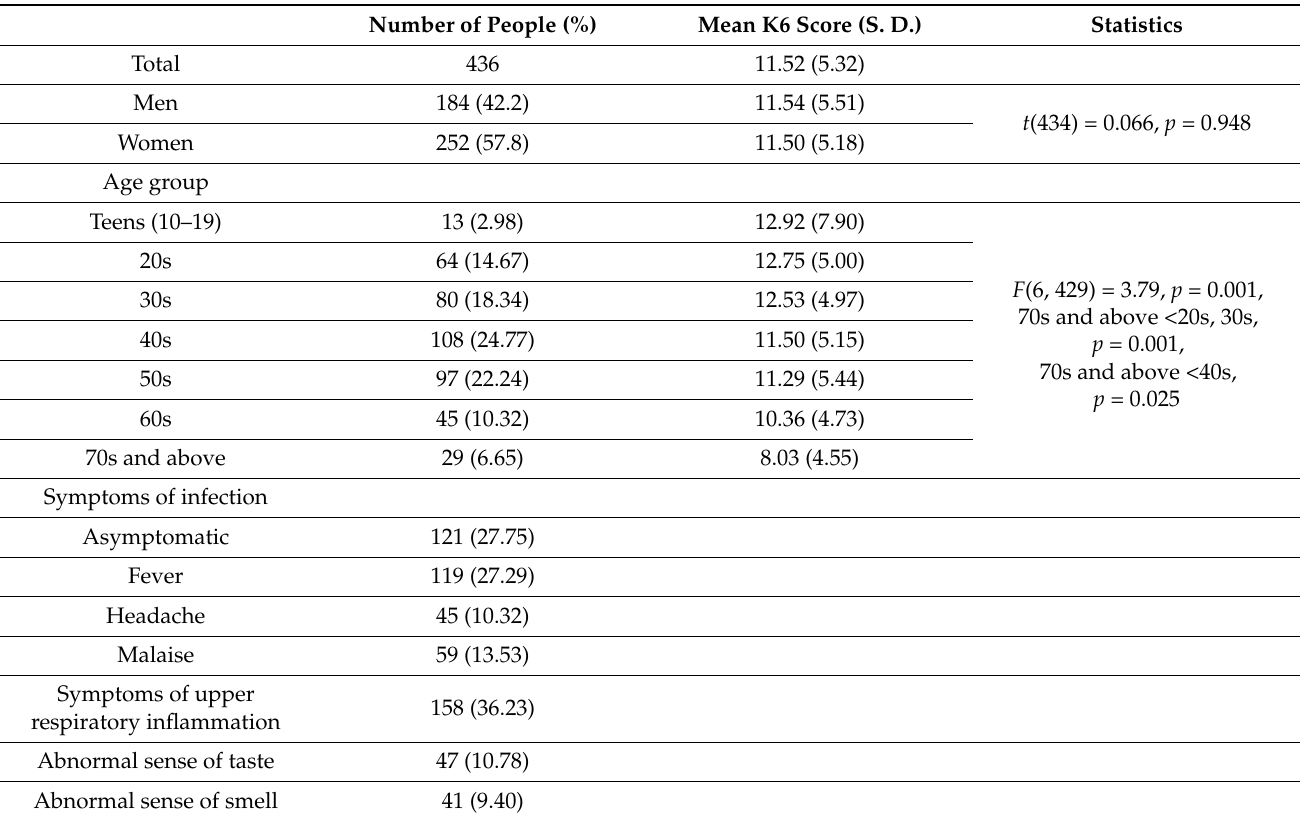
Table 1. Demographic characteristics of the study sample ( n =